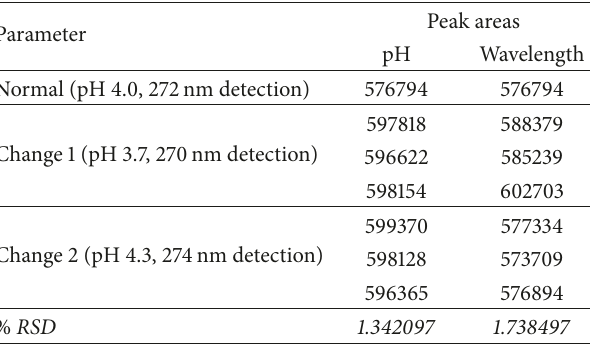
Table 6: Robustness